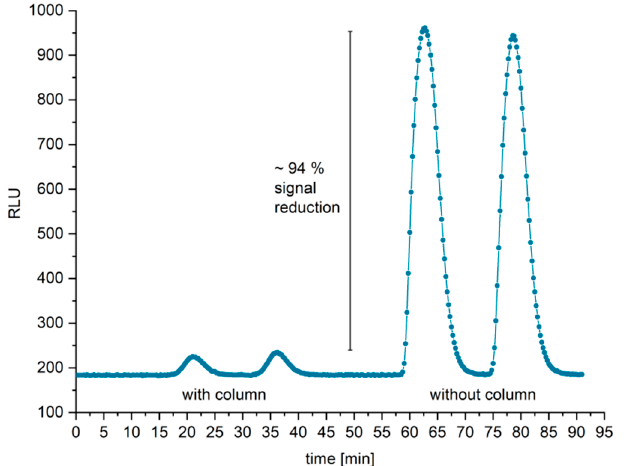
Figure 7. Performance test of the functionalized Pep188-199-SBAP-BSA column and the antibody– HRP conjugate (clone 9707). Injection of blank samples with and without affinity column resulted in a signal reduction of around 94% by applying a flow rate of 0.2 mL/min for each syringe pump. The signal reduction is an indication of conjugate purity and antibody activity.